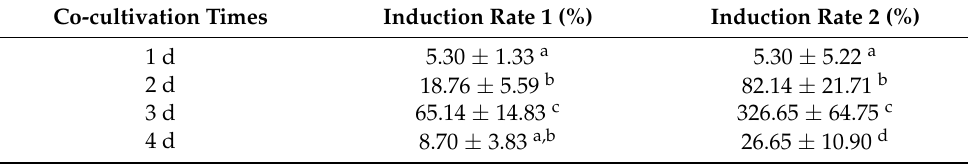
Table 3. Effect of co-culture times on induction.